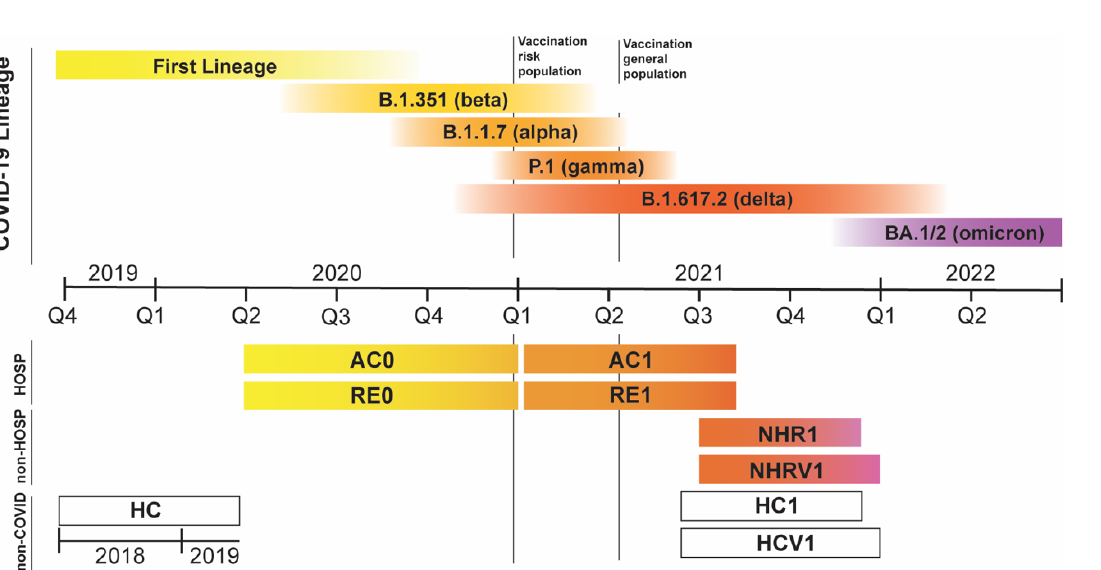
Figure 1. The COVID-19 disease time evolution, showing the approximate duration of the differ- ent lineages of the virus and the times when serum samples from the different cohorts were col- lected. The COVID-19 status and general characteristics of the cohorts are described in Tables 1 and S1–S3, respectively.